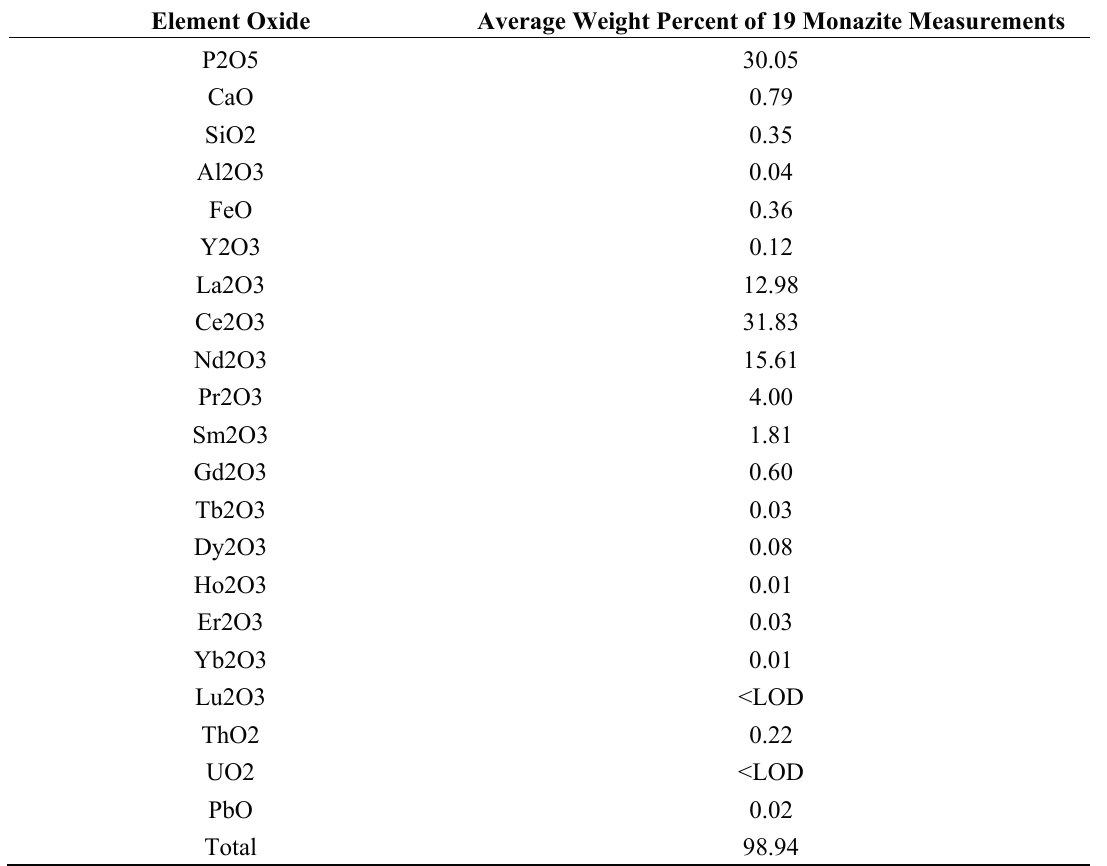
Table 4. Averaged elemental concentrations of 19 individual monazite crystals. All monazites are pure calcium carbonatite rocks, and due to the high amounts of cerium, all monazites are Ce-monazites. The presented values were determined by using electron microprobe